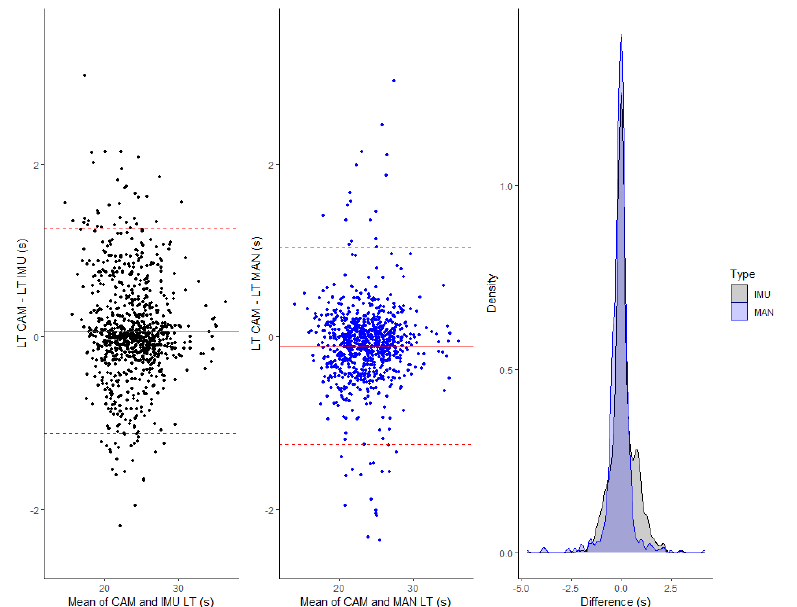
Figure 3. ( Left ) Bland–Altman plot of IMU and gold standard video, ( middle ) Bland–Altman plot of stopwatch and gold standard video, and ( right ) density distribution of difference between lap times assessed by IMU and gold standard video and by stopwatch and video.